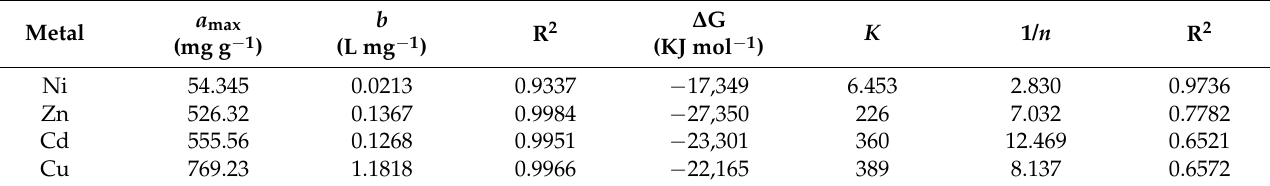
Table 5. Langmuir and Freundlich adsorption isotherm